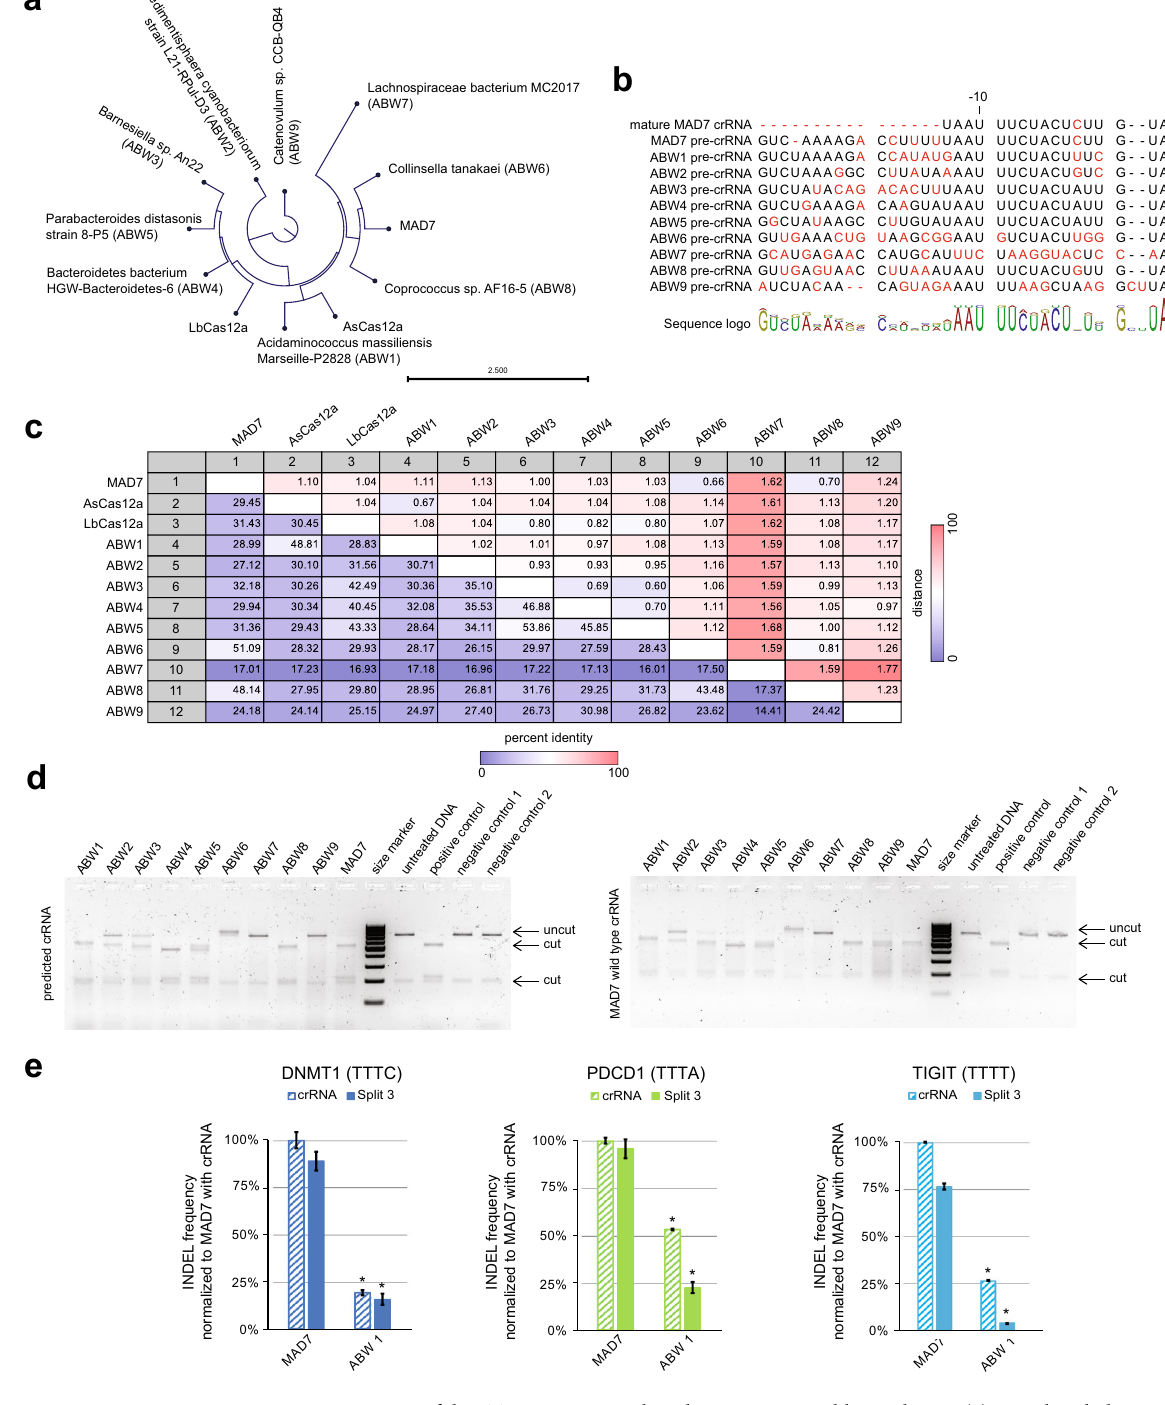
Figure 5. Extension of the STAR system to other class II type-V-A-like nucleases. ( a ) Circular phylogram reflecting evolutionary relationship of MAD7, AsCas12, LbCas12a, and ABW1-9. ( b ) Alignment of the MAD7 and ABW1-9 crRNAs with the mismatches indicated in red. ( c ) Similarity matrix (%) showing the percent identity of MAD7, AsCas12a, LbCas12a, and ABW1-9 amino acid sequences (lower left) and the evolutionary distance (upper right). ( d ) In-vitro cleavage assay on the amplicon containing the DNMT1 locus target sequence: nucleases with predicted ABW crRNAs (left) and with MAD7 wild-type crRNA (right), size marker: GeneRuler 100 bp DNA Ladder (ThermoFisher Scientific), cropped image. Original gel image is presented in Extended Data ( d ). ( e ) INDEL frequency (%) of ABW1 and MAD7 with MAD7 wild-type crRNA and Split 3 STAR-crRNA targeting the DNMT1, PDCD1, and TIGIT loci, measured by amplicon sequencing (error bars: mean ± SEM for n ≥ 3). ABW1 samples indicated with asterisk show significant decrease in INDEL frequencies compared to MAD7 with wild-type crRNAs, P ≤ 0.05 using two-sided t -test after a global one-way analysis of variance (ANOVA). The sequences of all crRNAs used are listed in Supplementary Table